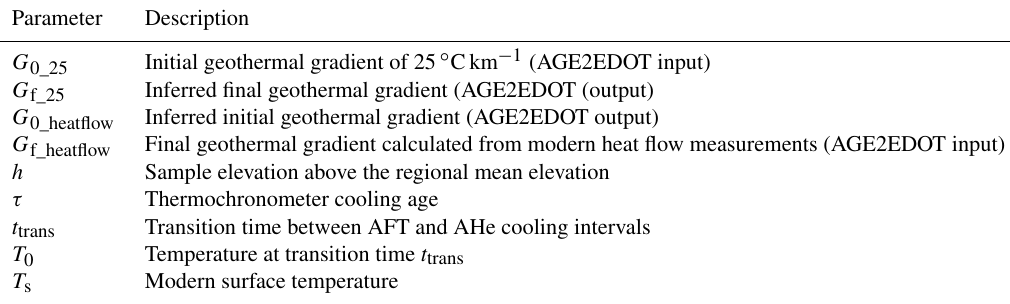
Table 1. Definitions of thermal parameters used in the erosion rate